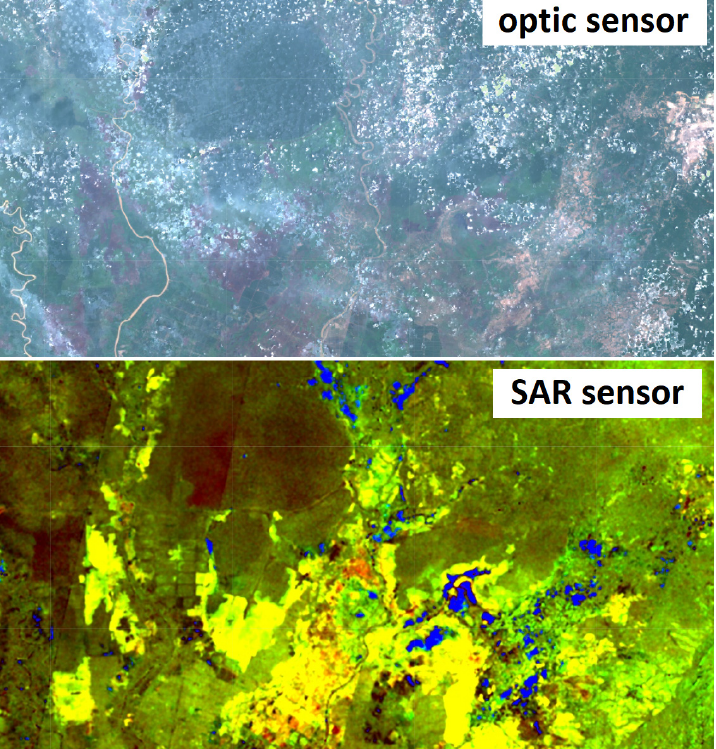
Figure 2. The advantages of the SAR data, compared to the optical sensors for the detection of the burn scar areas where visually, it is not covered by clouds and smoke. burn scar areas where visually, it is not covered by clouds and